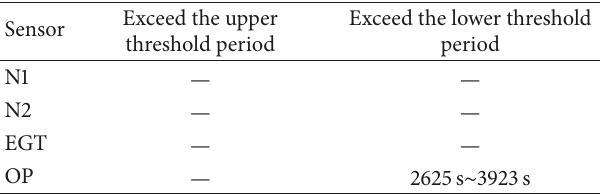
Table 2: The period of every sensor exceeding the